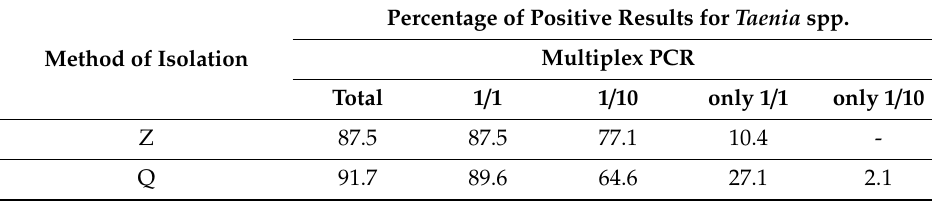
Table 3. Percentages of PCR Taenia spp. positive results (multiplex